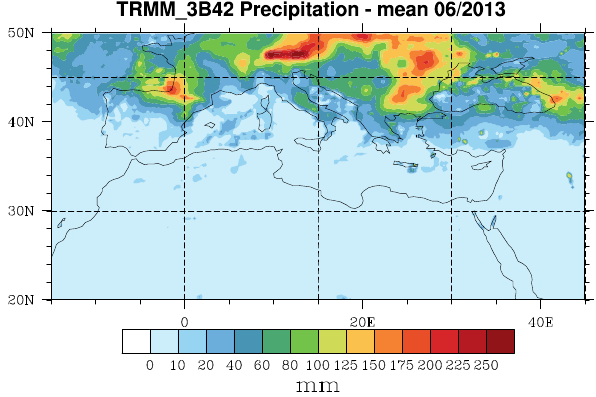
Figure 11. Same as Fig. 10 but for the Tropical Rainfall Measuring Mission (TRMM) precipitation